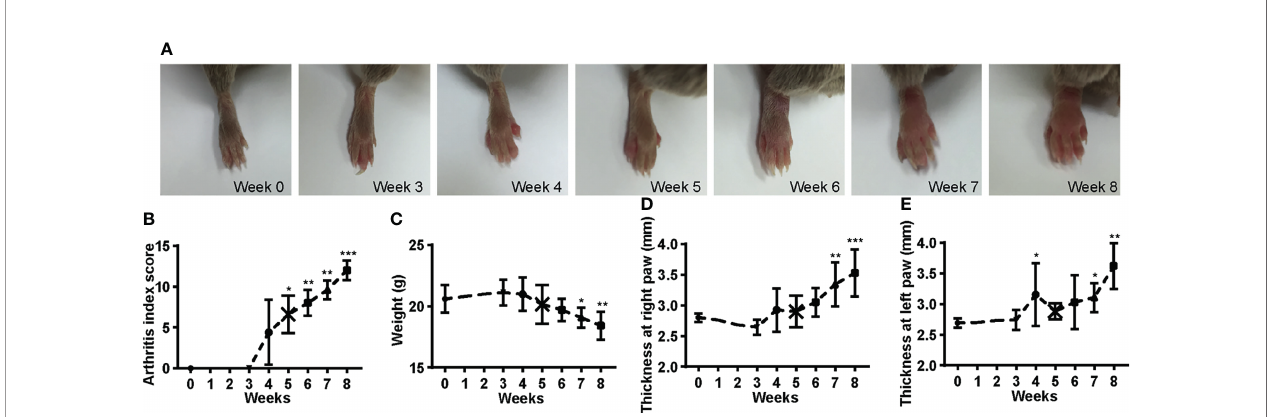
FIGURE 1 | Development of CIA mice. (A) The hind paws show from mild to pronounced edematous swelling and eventually ankylosis over the disease course. (B) The arthritis score increased with time. (C) The body weight decreased over the onset of the disease. (D – E) The thickness of the hind paws increased over time. ANOVA with post-hoc Dunnett ’ s T3 test for (B) and ANOVA with post-hoc LSD test for (C – E) ; *p < 0.05, **p < 0.01, ***p < 0.001 vs. week 0. n = 5 per group. Results are representative of three independent